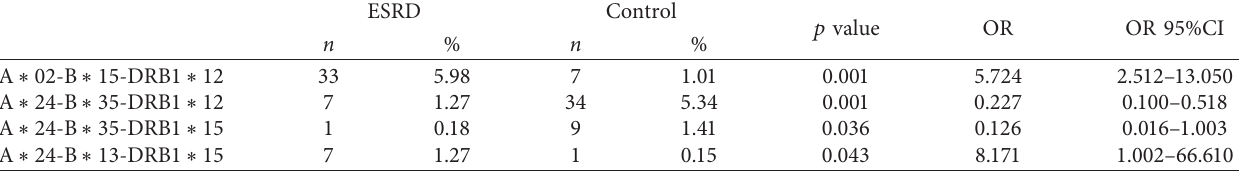
Table 4: Association of three-locus haplotypes with